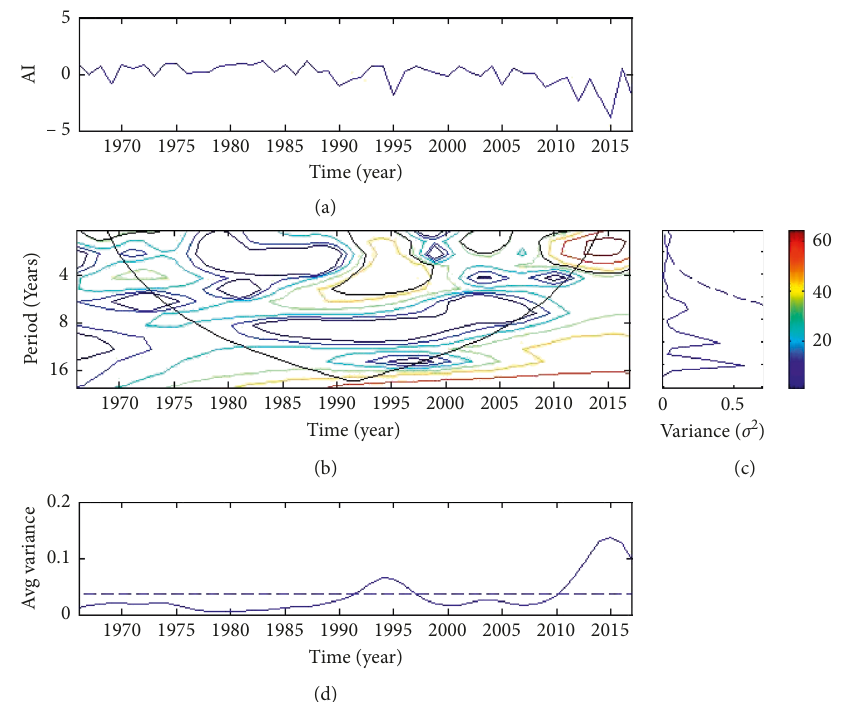
0 time series used for the